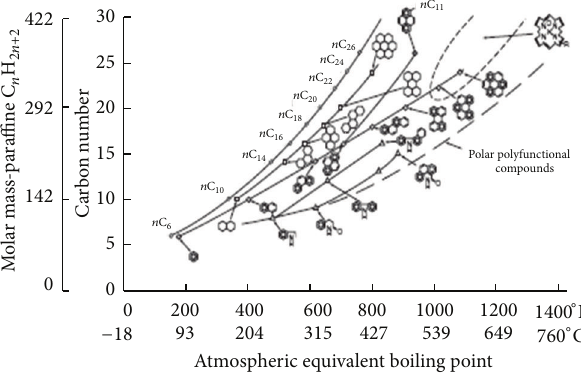
Figure 5: Evolution of molecular weights and structures as a function of the boiling point